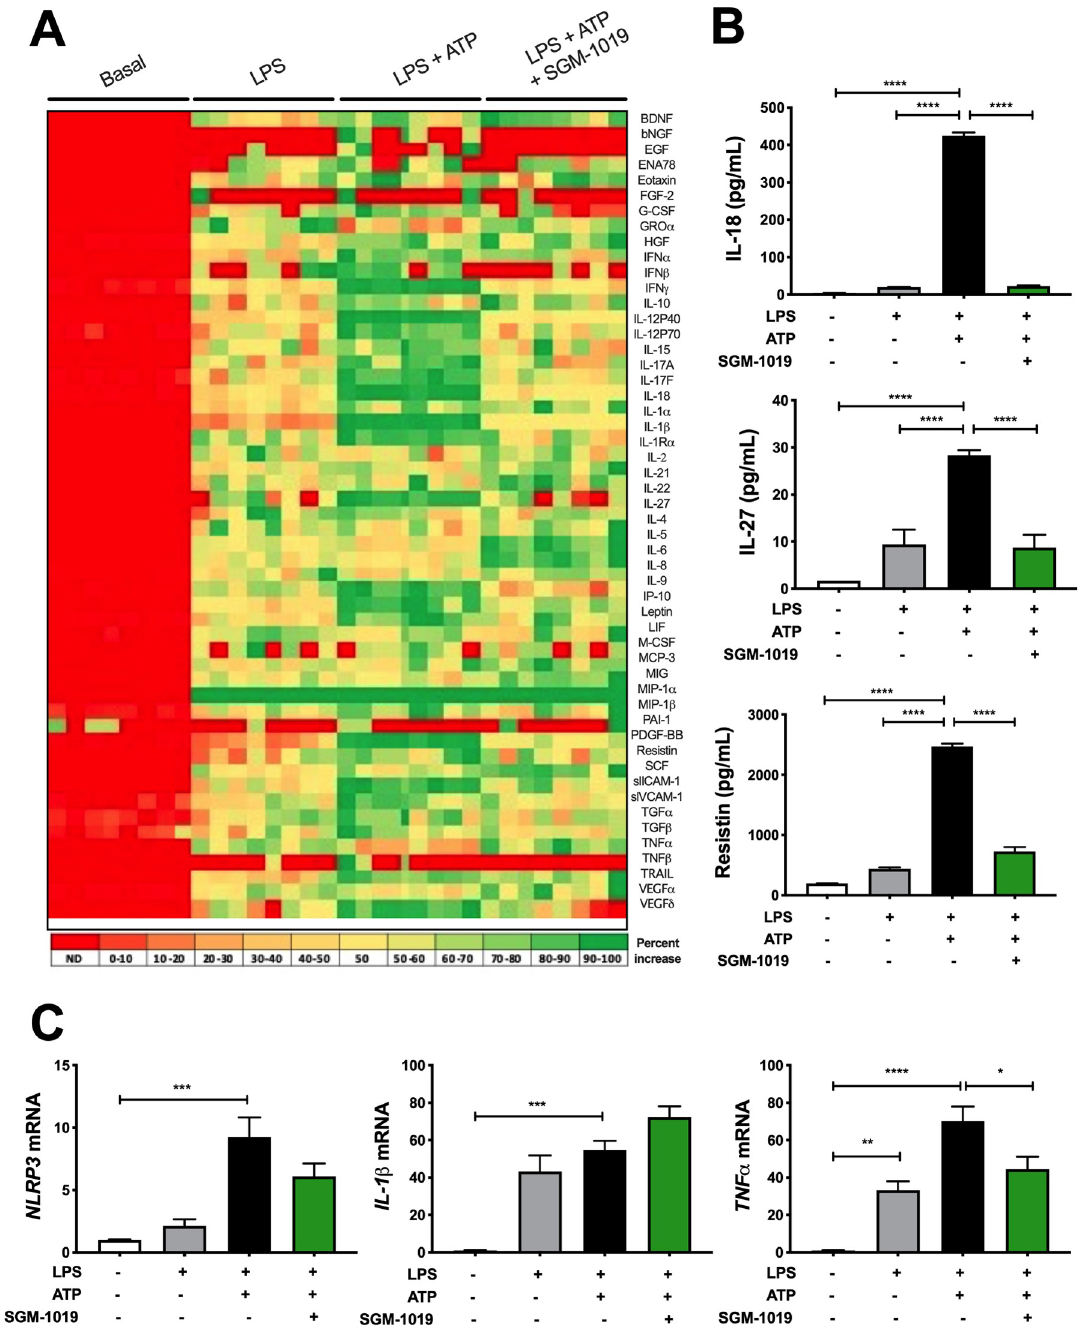
Fig 3. Inhibition of P2RX7 alters the secretion of cytokines in MOs. (A) Heat map showing levels of cytokines and growth factors present in the culture media from MOs treated with LPS, ATP ± SGM-1019. Red indicates low relative expression, and green indicates high relative expression. (B) IL-18, IL-27 and resistin levels in culture media from MOs treated with LPS, ATP ± SGM-1019. (C) Relative expression of NLRP3 , IL-1 β , and TNF α in MOs treated with LPS, ATP ± SGM-1019. In heat map, red indicates low relative expression, and green indicates high relative expression. n.d., for not detected. In all statistical plots, the data are shown as the mean ± SEM. � P � 0.05, �� P � 0.01, ��� P � 0.001, ���� P � 0.0001 by one-way ANOVA.